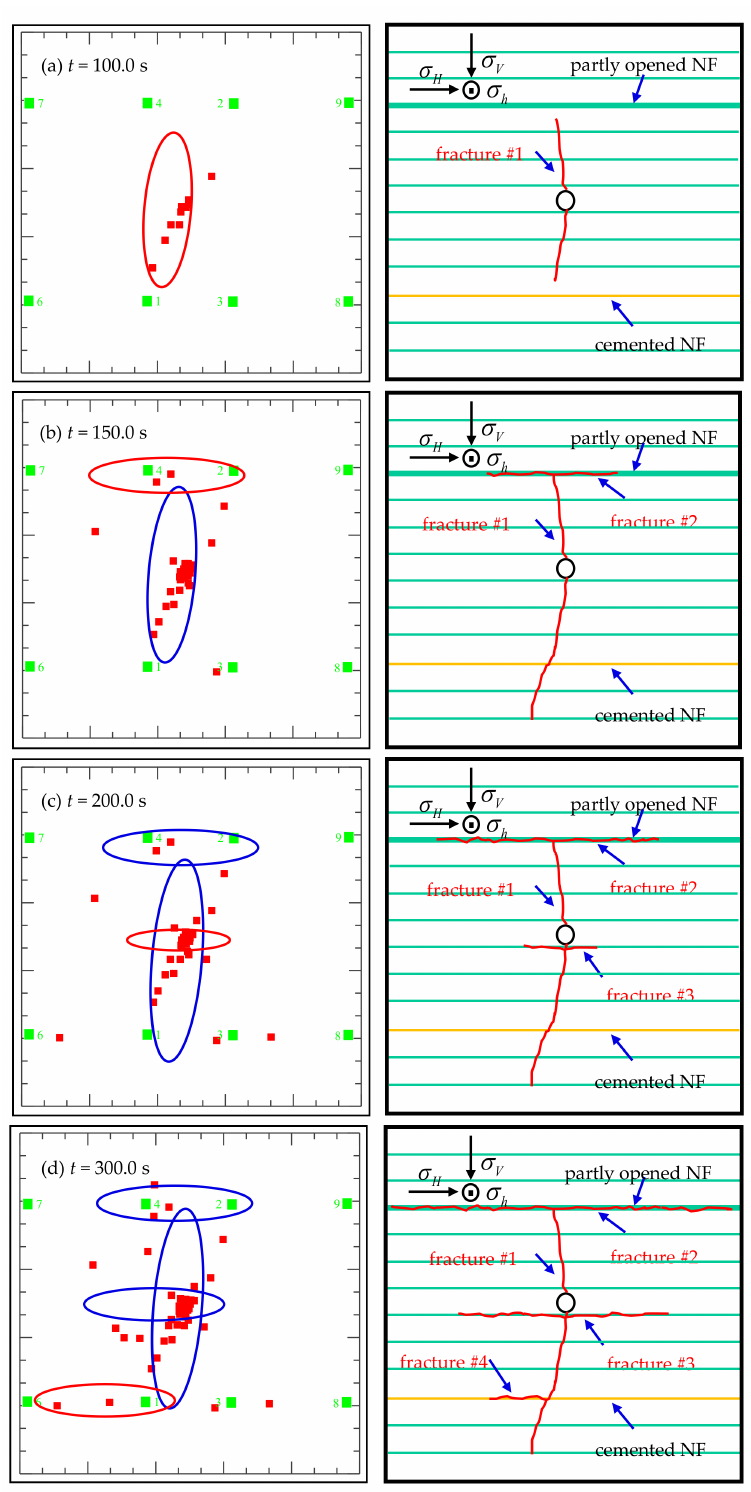
Figure 22. AE detection results of specimen Y-7-3 after conducting